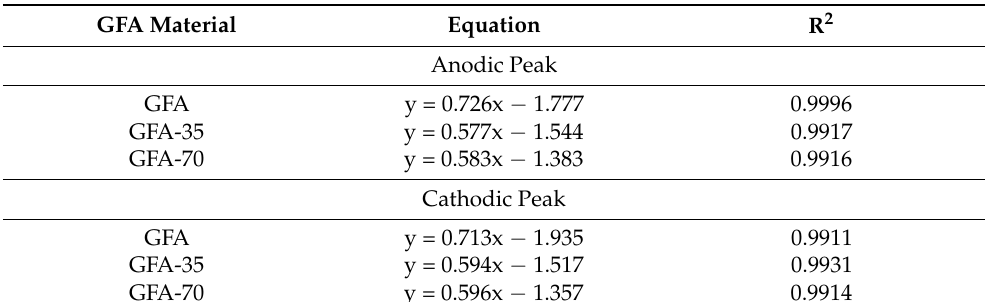
Table 3. Dependences of log I p vs. log v determined for the tested GFA materials in K 4 [Fe(CN) 6 ] (5